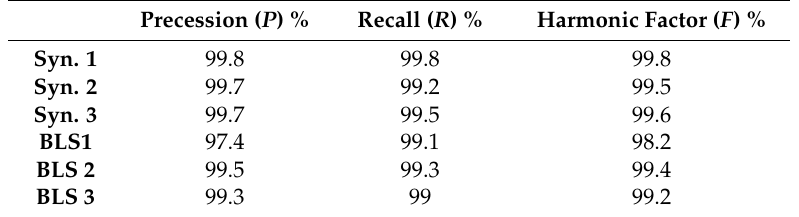
Figure 8. ( a – f ) Evaluation of reconstructed models from synthetic datasets: ( a – c ) Comparison of the 2D floor plans (black lines) and reconstructed models (colored lines), and ( d – f ) distance of points to the nearest reconstructed plane (a histogram of errors is shown at right side). ( g – l ) Evaluation of reconstructed models from BLS: ( g – i ) Comparison of the 2D floor plans (black lines) and reconstructed models (colored lines), and ( j – l ) distance of points to the nearest reconstructed plane (a histogram of errors is shown at right side). Table 3. Evaluation of the reconstructed models compared to reference 2D floor